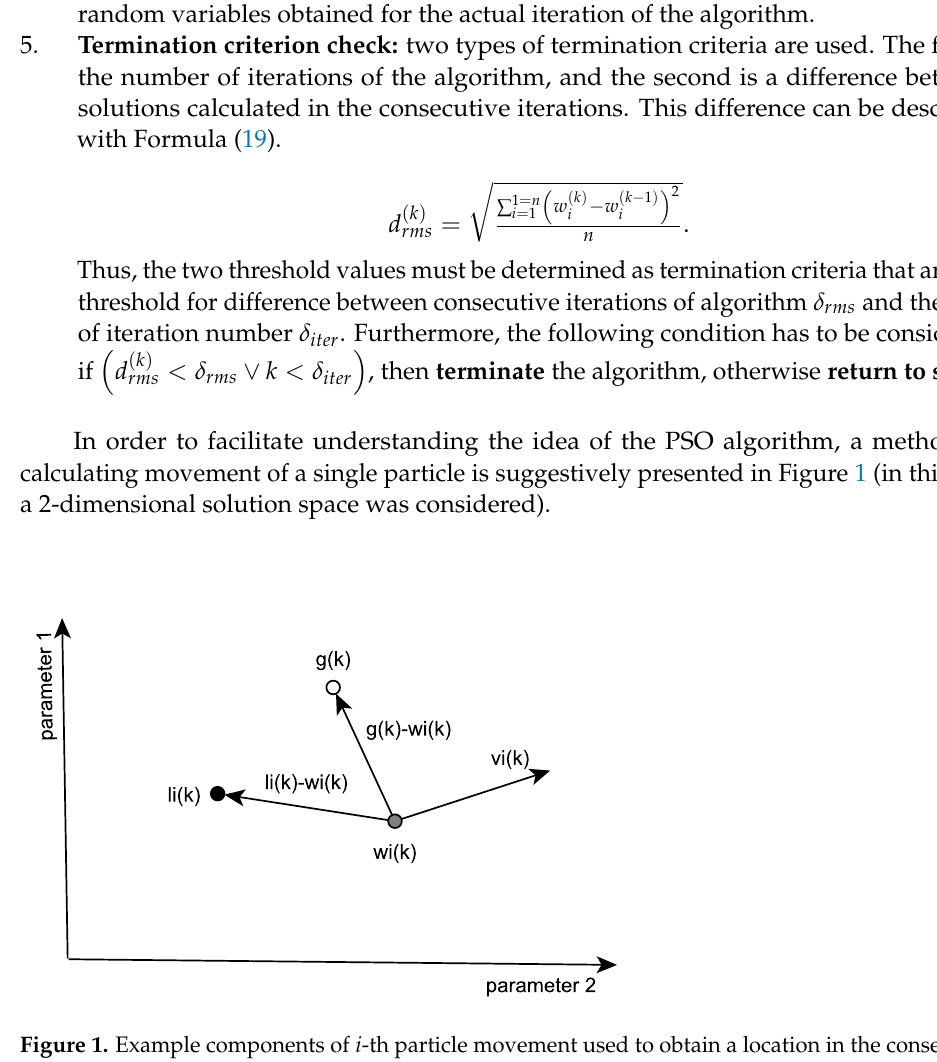
Figure 1. Example components of i -th particle movement used to obtain a location in the consecutive iteration of the algorithm in two-dimensional solution